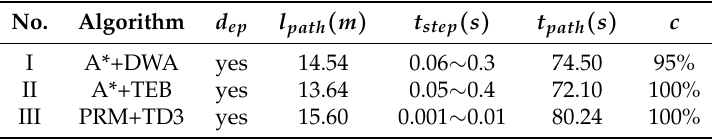
Table 3. Planning indexes in small-scale